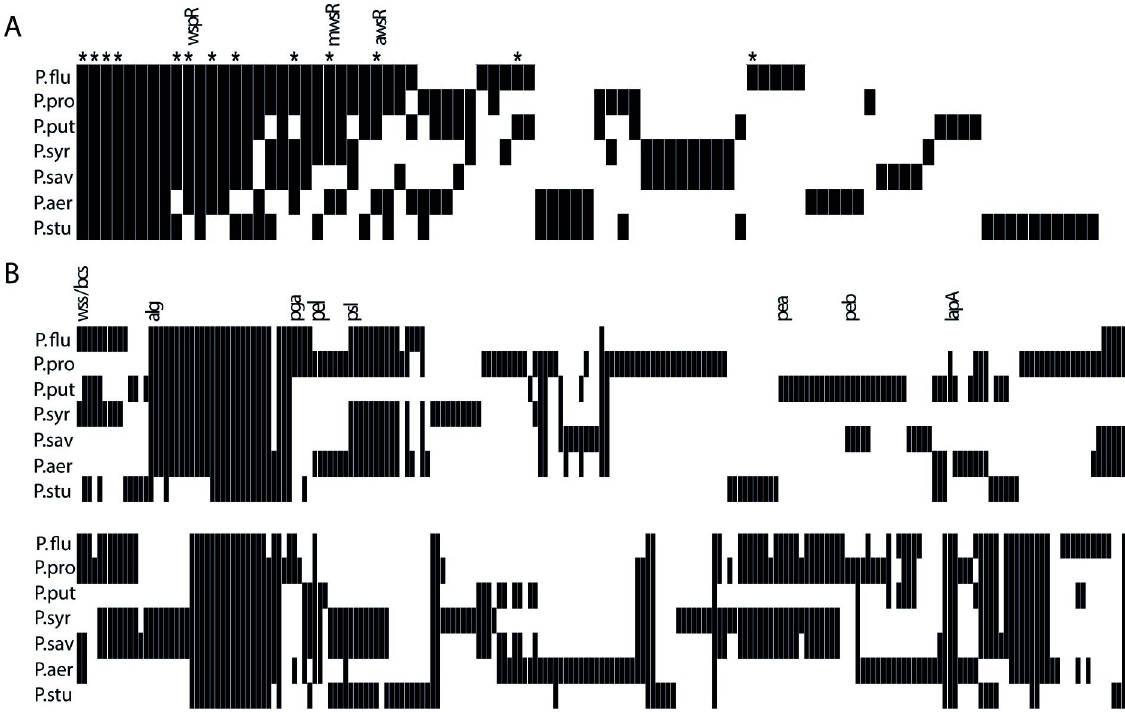
Fig 7. Diversity of DGCs and biofilm-related genes for seven Pseudomonas species. ( A ) Five other Pseudomonas species ( P . putida KT2440, P . syringae pv. tomato DC3000, P . savastanoi pv. phaseolicola 1448A, P . aeruginosa PAO1, P . stutzeri ATCC 17588) were chosen based on phylogenetic diversity to extend predictions. Including P . fluorescens SBW25 and P. protegens Pf-5, the seven species encode 251 putative DGCs, divided into 87 different homolog groups of which 8 are present in all genomes. WS mutations in SBW25 have been found affecting 13 of these DGCs (marked with � ) with an additional nine that have been detected only in combinations with other mutations. SBW25 and Pf-5 share 33 DGCs with 6 unique for each species. It should be noted that not all DGCs are likely to be catalytically active. ( B ) Diversity of biofilm- related genes including putative EPSs, LPS modification, cell chaining, adhesins and known regulators. The genomes of the P . aeruginosa strains PA7, UCBPP-PA14 were also included in the analysis and results were in most cases identical to PAO1 (not shown in Fig 7) except for an absence of homologues for EPS genes pelA-D and the DGCs PA2771 in UCBPP-PA14 and PA3343 in PA7. Detailed information is available in S4